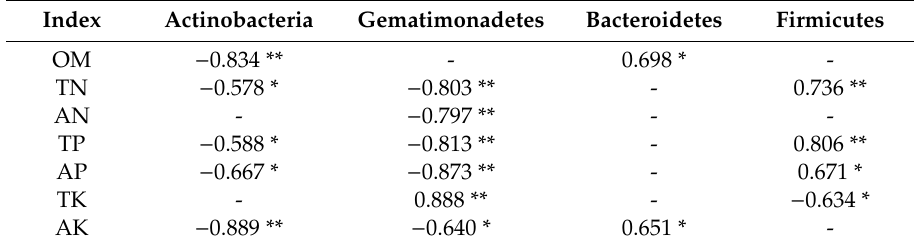
Table 6. Correlations of Rhizosphere Soil Physicochemical Properties with bacterial